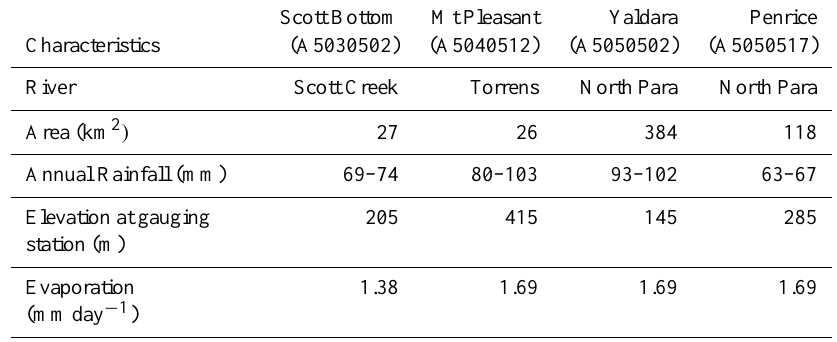
Table 2. Geographical, climatic and meteorological data of the study catchments.